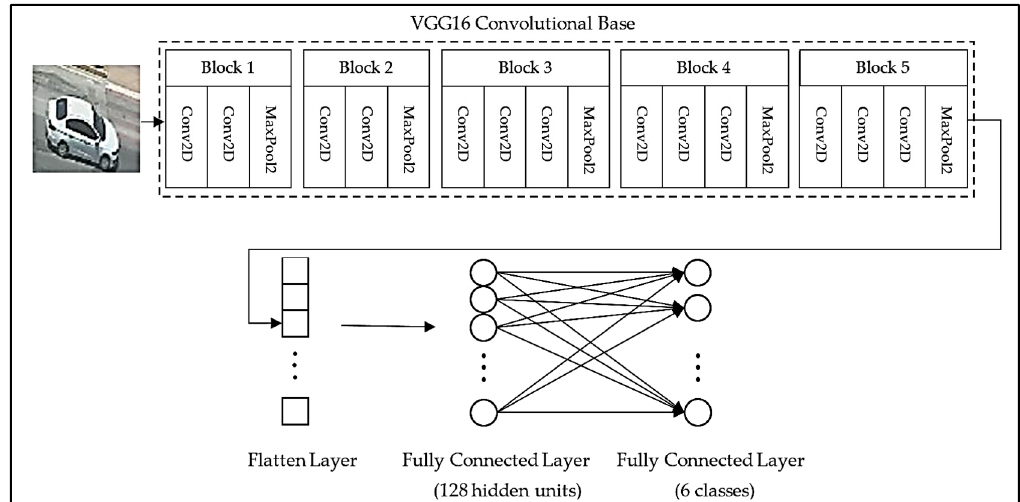
Figure 2. Architecture of the VGG16 pre-trained model.